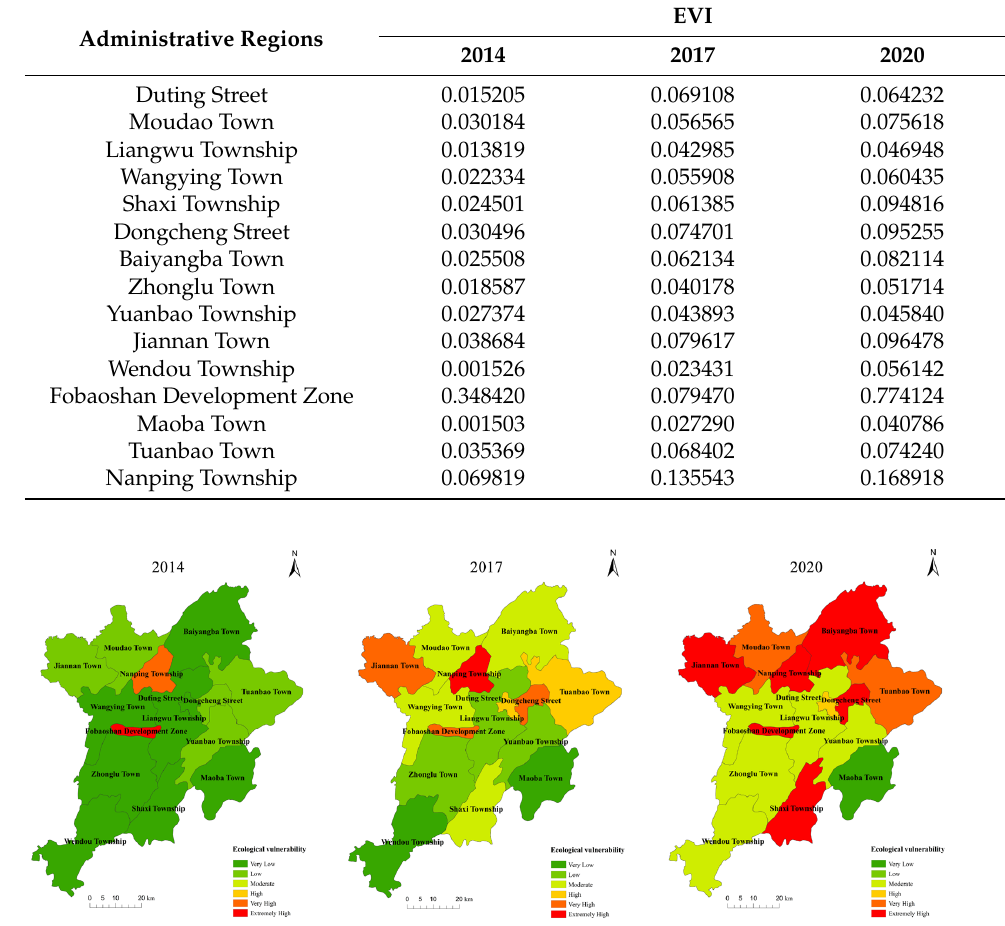
Figure 5. Distribution of ecological vulnerability in the audit sample in 2014, 2017 and 2020.